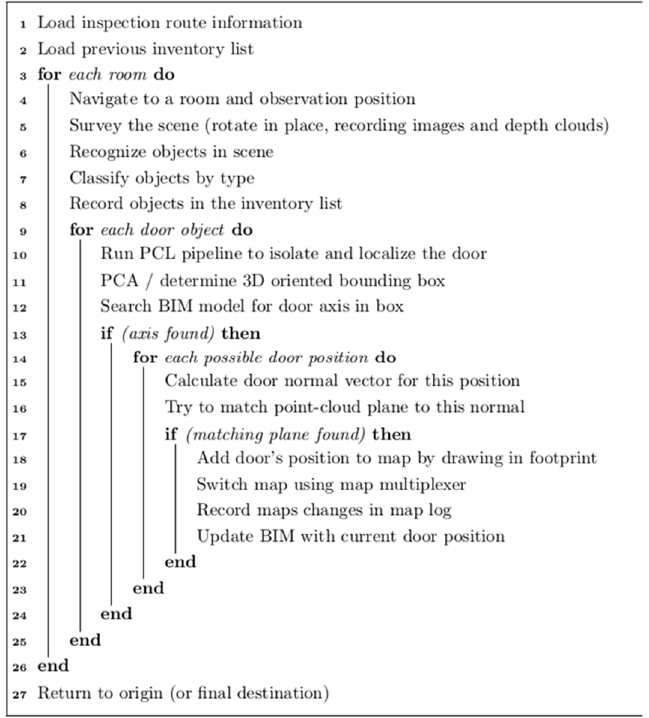
Figure 7. Pseudo code identifying doors and insertion into navigation map and BIM.